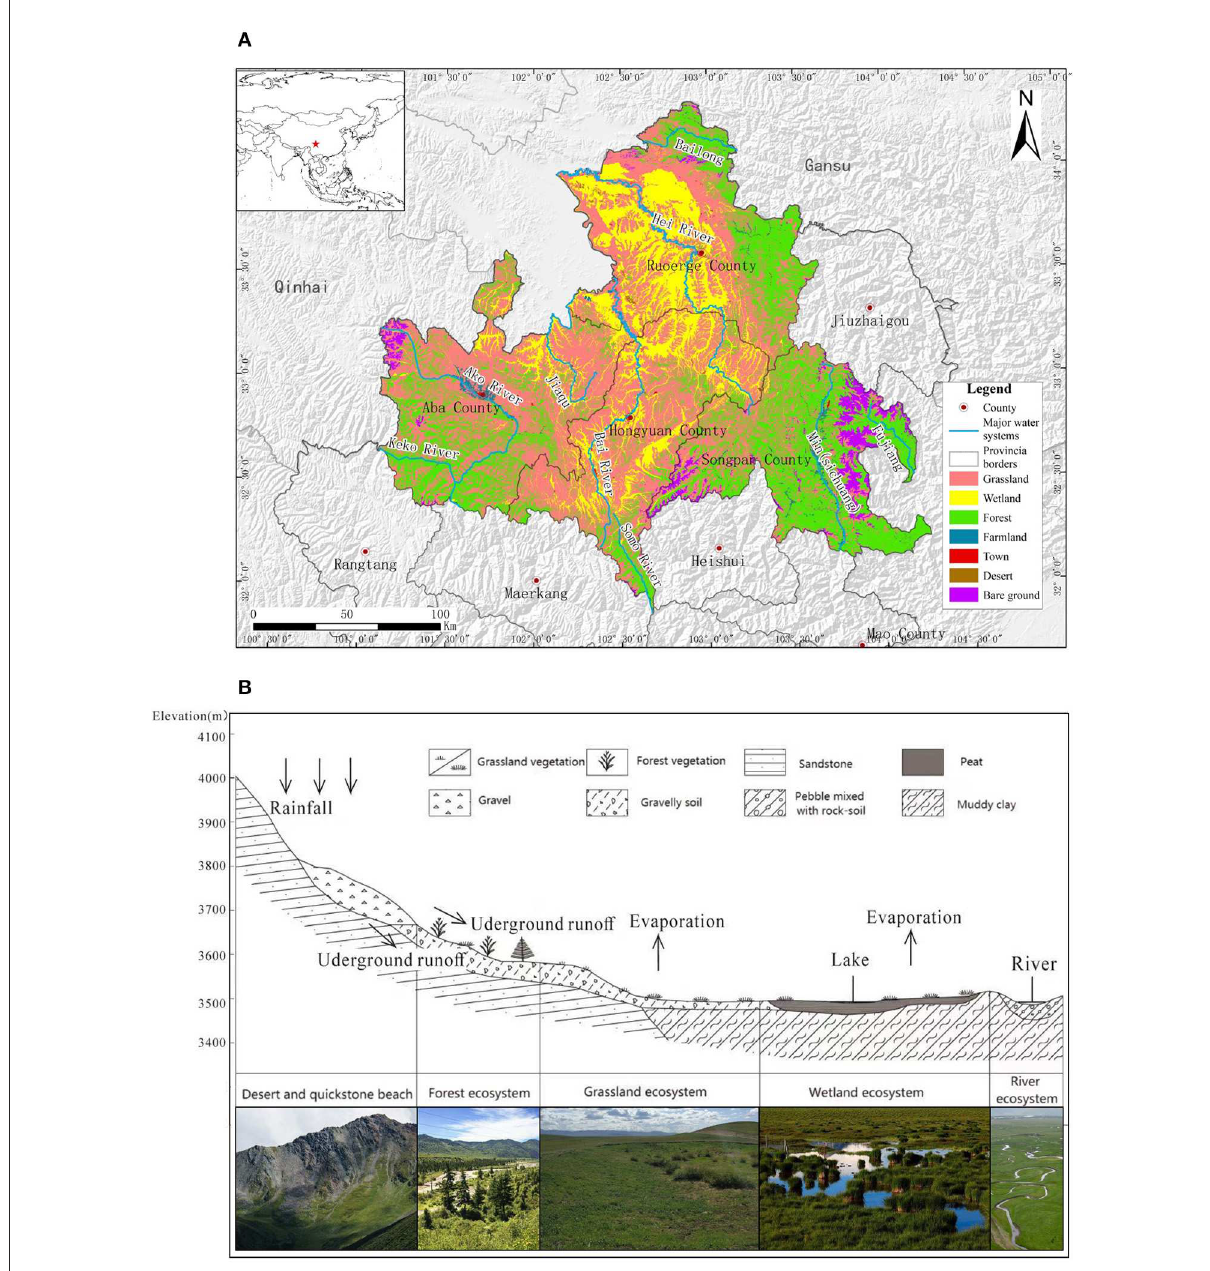
FIGURE1 Ecosystem distribution in the study area. (A) Ecosystem types. (B) Ecosystem